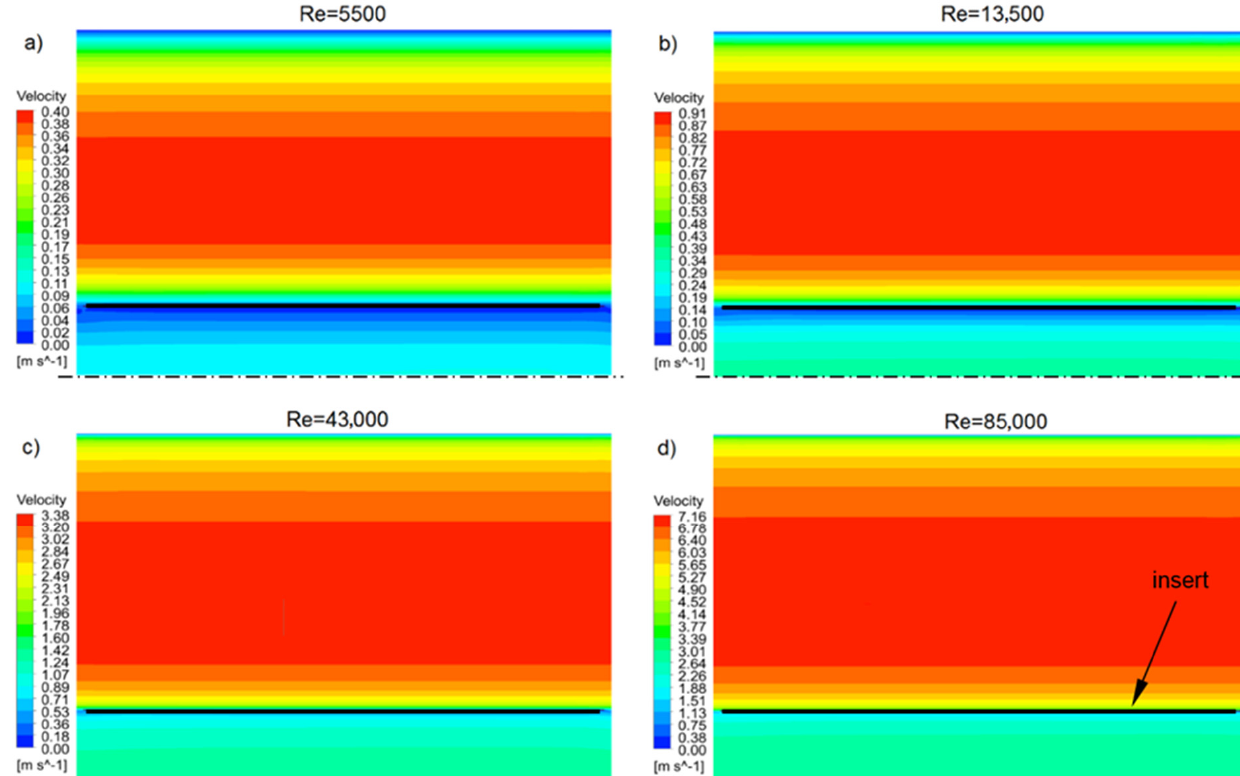
Figure 5. Velocity profiles in the symmetry plane for dimensionless insert diameter D = 0.2 and different Re numbers: ( a ) Re = 5500, ( b ) Re = 13,500, ( c ) Re = 43,000 and ( d ) Re =